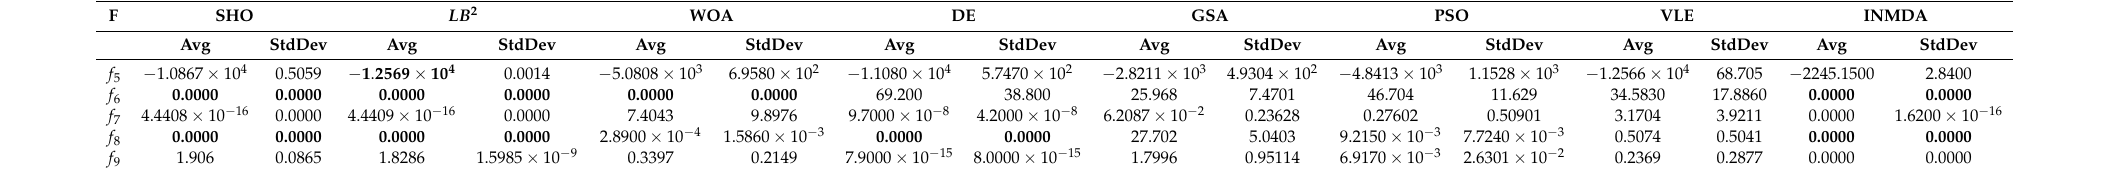
Table 7. Results comparison in multimodal benchmark functions.